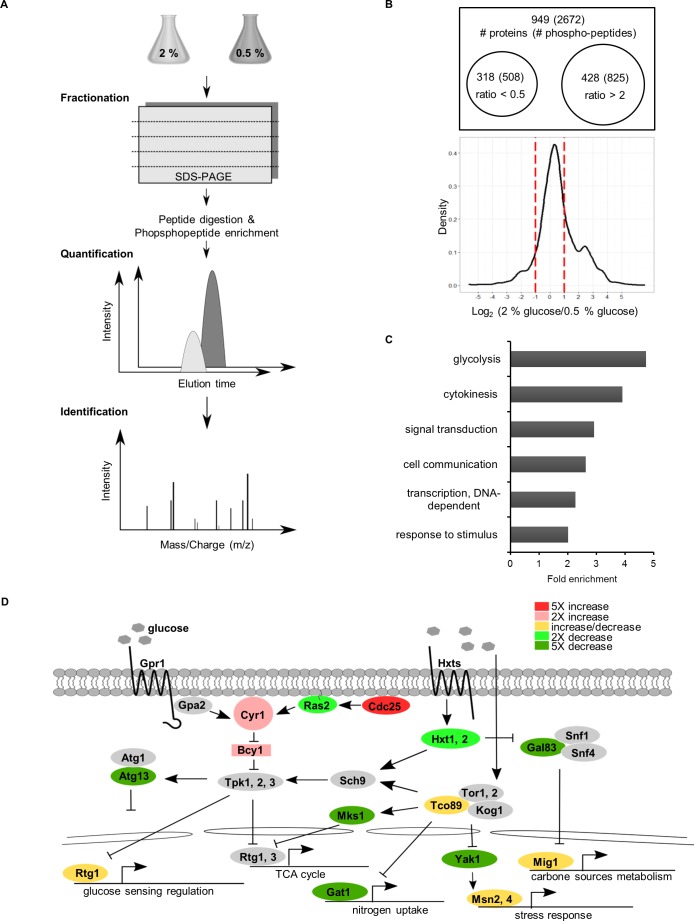
The strategy used for large-scale identification of CR-modulated pathways.(A) Experimental workflow for quantitative proteomics-identified CR-regulated proteins in yeast. (B) Venn diagrams represent the increased abundance of phosphorylated peptides (proteins) under normal conditions compared to CR by over 50% (log2 >1) or the decreased abundance of phosphorylated peptides (proteins) under normal conditions versus CR treatment by over 50% (log2 < −1). The distribution of log2 (2% glucose/0.5% glucose) ratios for phosphopeptides are illustrated by a density plot. (C) GO term analysis of phosphorylated proteins regulated by CR. The top six enriched biological processes are shown. (D) Some phosphoproteins regulated by CR are factors in the glucose-sensing pathway. The phosphoproteins with a greater than 2-fold change are labeled with different colours to indicate their ratios. The phosphoproteins containing both phosphorylation and dephosphorylation sites under CR are labeled in yellow.